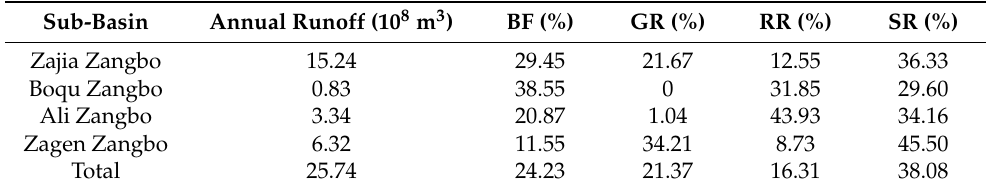
Table 4. Runoff composition and contribution to total runoff in each sub-basin of Siling